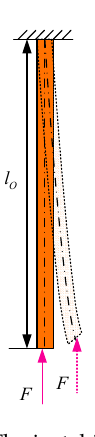
Figure 11. Influences of x o , y o , and E on F o ( r = 0.02 m, R o = 0.01 m, l = 0.03 m, r p = 0.003 m, N = 12, p o = 1.01 × 10 5 Pa, and p i = 0.8 p o ).